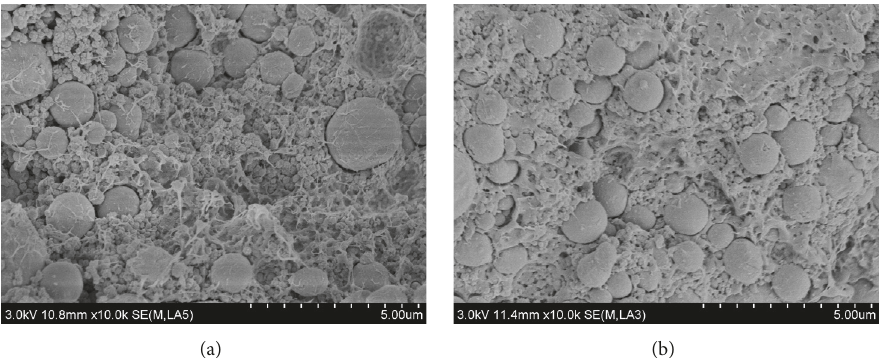
Figure 3: The microstructures of PTFE/Al/Fe 2 O 3 composites. (a) Type A specimen and (b) type B